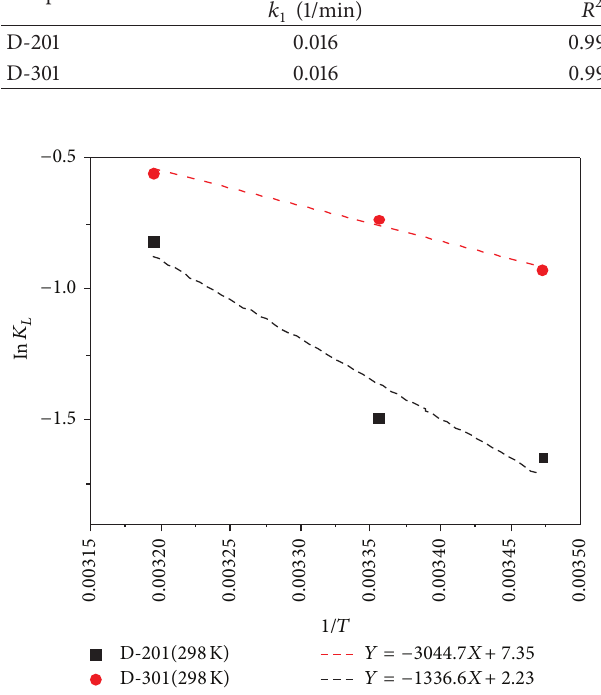
Figure 2: Van’t Hoff plot for the adsorption of MBP onto D-201 and D-301.